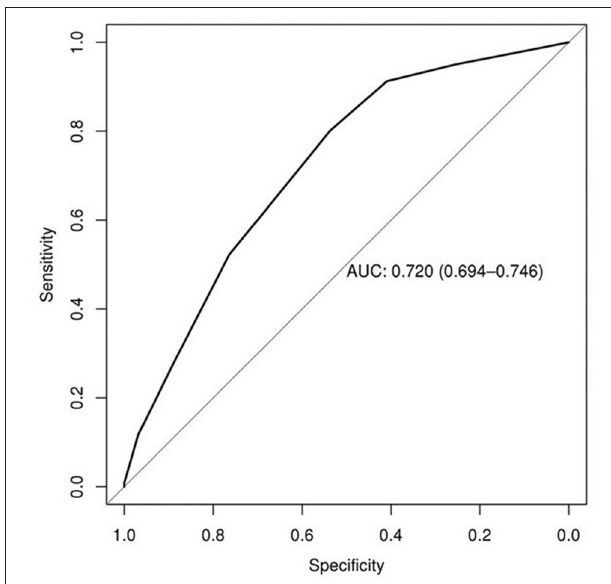
FIGURE 2 | AUC receiver operating characteristic curve. AUC indicates area under the curve.